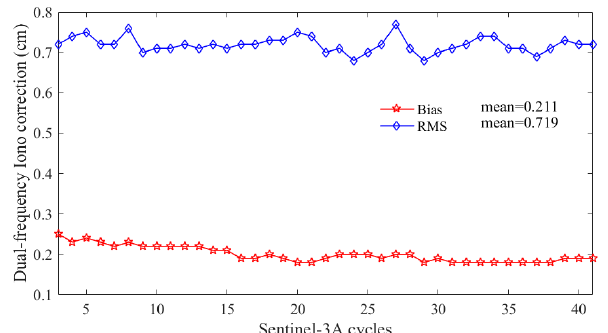
Figure 6. Cycle by cycle ( a ) means and ( b ) standard deviations of ionospheric corrections according to Sentinel-3A repeat cycles.